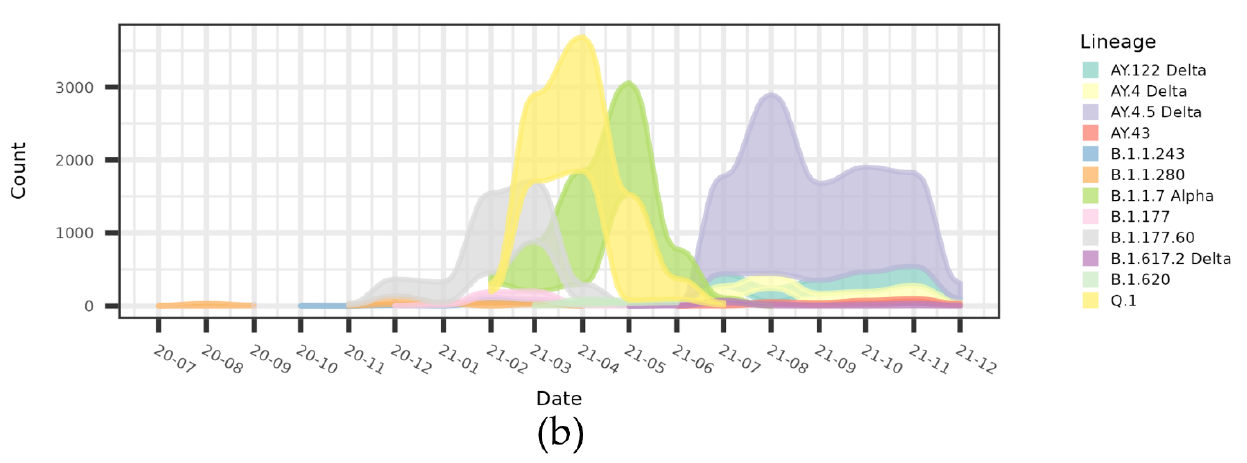
Figure 1. The most prevalent lineages in Lithuania. ( a ) Counts of the most prevalent lineages based on GISAID data by the end of 2021—data on the most frequent lineages that make up 90% of all cases are given (separated by blue box line). “VOC” denotes variants of concern, “VUM” denotes variants of interest/under monitoring, and “PMV” denotes lineages that fell into any of the “special” categories in the past. ( b ) The dynamics of absolute count for the lineages which makes up >0.50% of all cases.